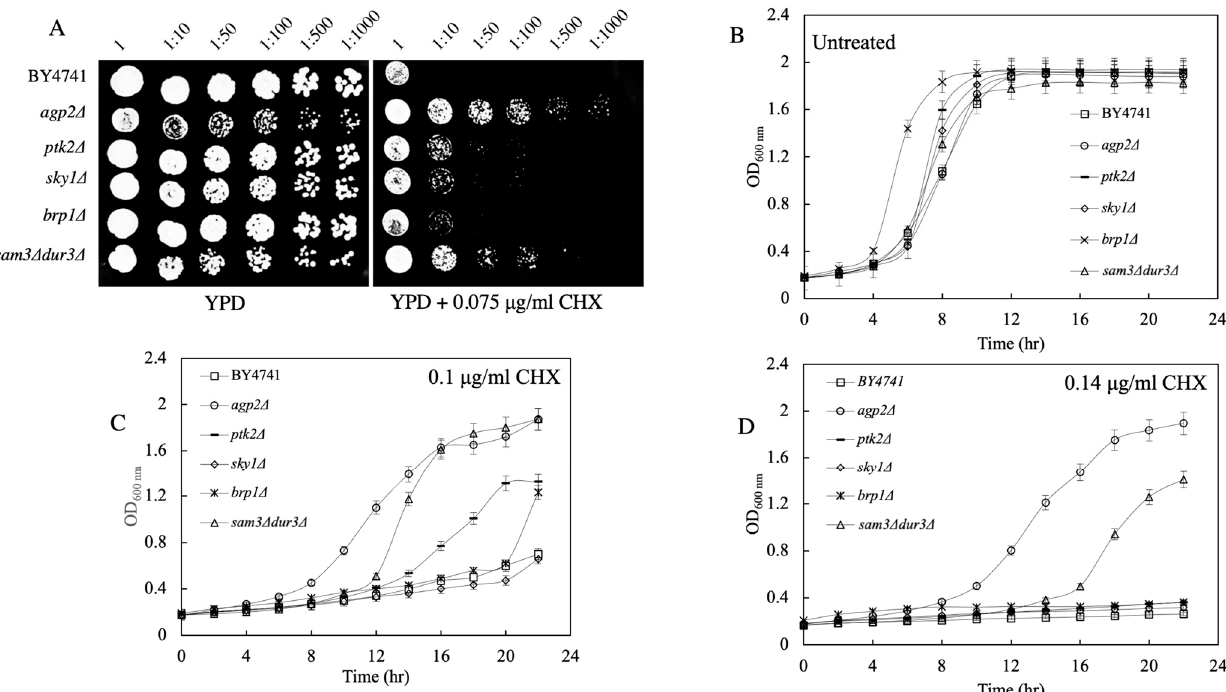
5 of 20 Figure 3. Docked complex structure representing Agp2 bound with CHX. ( a , b ) show the ribbon and surface representation of Agp2 in yellow and CHX in blue. ( c ) Ligplot interaction map of Agp2-CHX complex. The analysis suggests that CHX is a substrate that can be recognized by Agp2. The Agp2–CHX interactions were visualized using LigPlot+ (Figure 3c) [27]. Hydrogen bonds